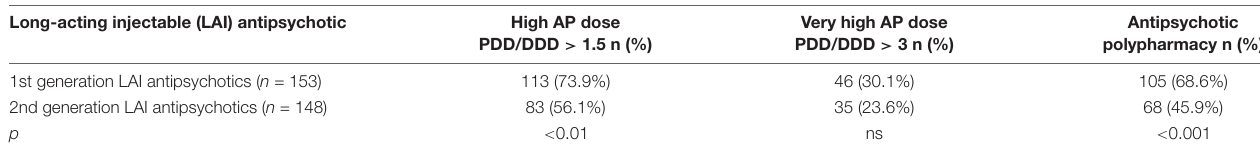
TABLE 5 | Long-acting injectable (LAI) antipsychotics, high dose/very high-dose antipsychotic regimens, and antipsychotic polypharmacy. Long-acting injectable (LAI) antipsychotic High AP dose No LAI antipsychotic (n = 318) 120 (37.7%)